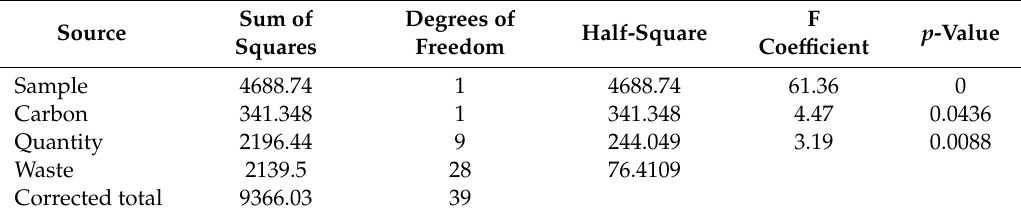
Table 3. Results of analysis of variance for COD removal efficiency.